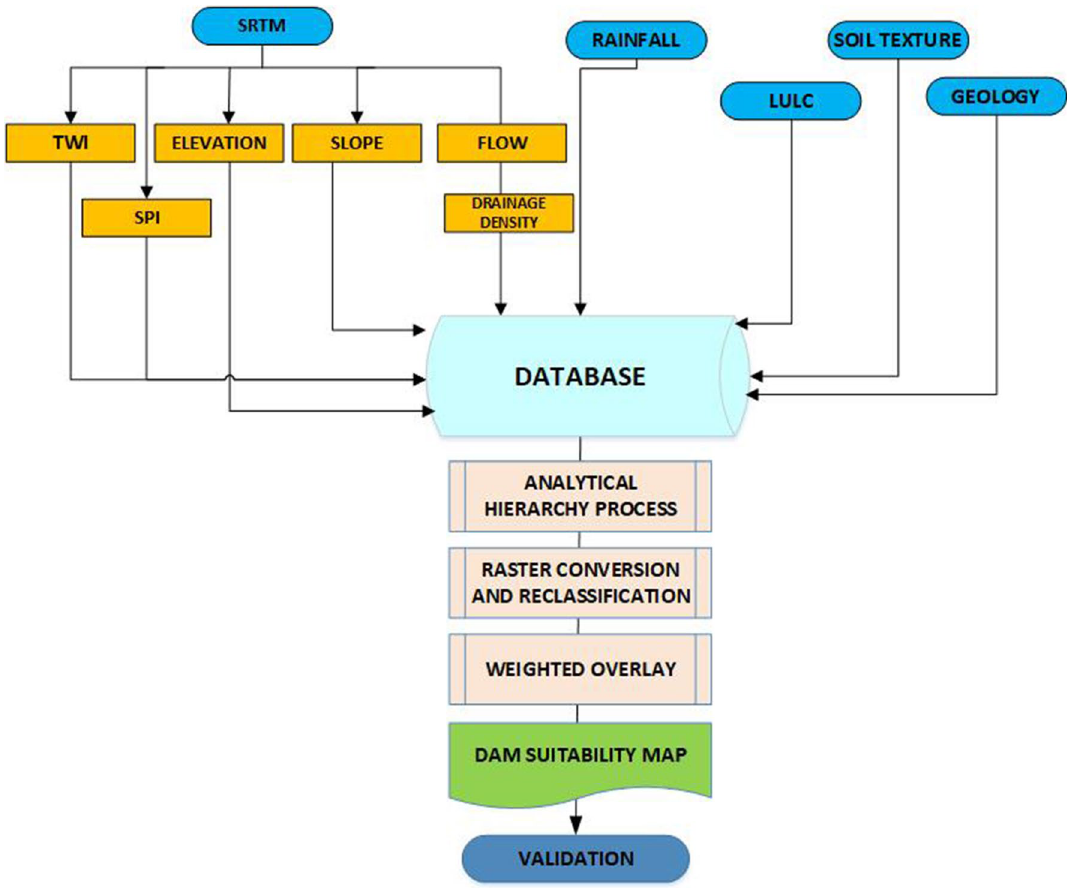
Fig. 2 Methodology flow